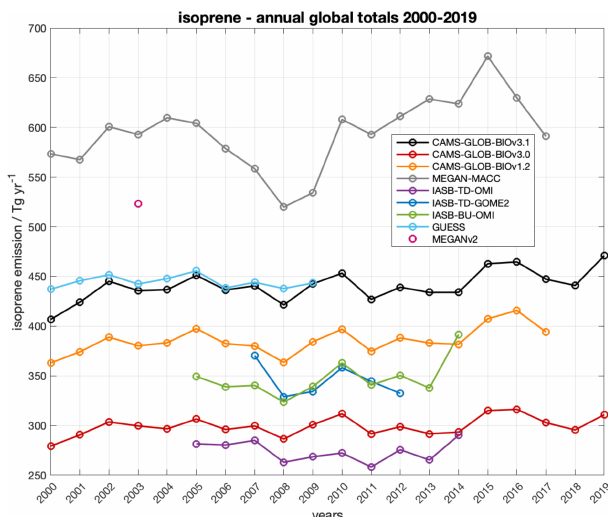
Figure 6. Isoprene monthly totals in Europe in the year 2016 from CAMS-GLOB-BIO datasets (v3.1, v3.1 without EP update and v1.2) and EMEP model.